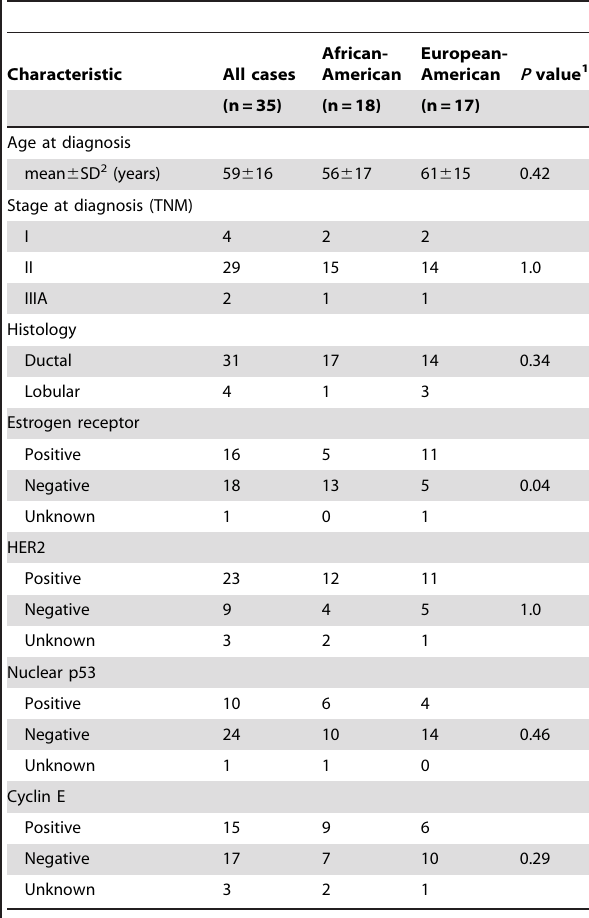
Table 2. Clinical characteristics of the microdissected breast